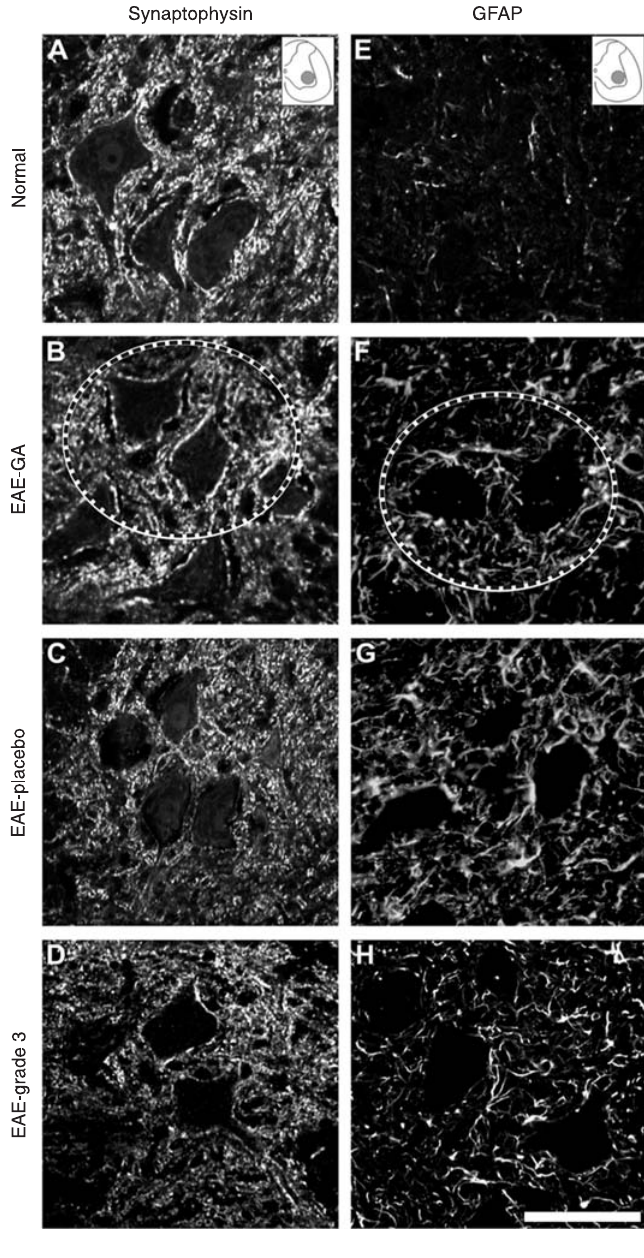
Figure 1. Photomicrographs obtained at the level of the spinal cord ventral horn (L4-L5) showing the preservation of synaptophysin and an increase in GFAP and F4/80 during the EAE peak, followed by glatiramer acetate treatment. Panels A-D, Immuno- labelling against synaptophysin in the normal (A), EAE-GA (B), EAE-placebo (C), and EAE-grade 3 (D) animals. Observe the preservation of inputs in the EAE-GA-treated group (dashed circle in B). Panels E-H, Immunofluorescence micrographs showing astrocyte reactivity in the normal (E), EAE- GA (F), EAE-placebo (G), and EAE-grade 3 (H) animals. Note that a certain degree of astrogliosis is still present in the EAE-GA group, although the clinical signs of the disease have been ameliorated (dashed circle in F). Scale bar = 35 μ m for all panels. GFAP = glial fibrillary acidic protein; EAE = experimental autoimmune encephalomyelitis; GA = glatiramer acetate; grade 3 = hind leg